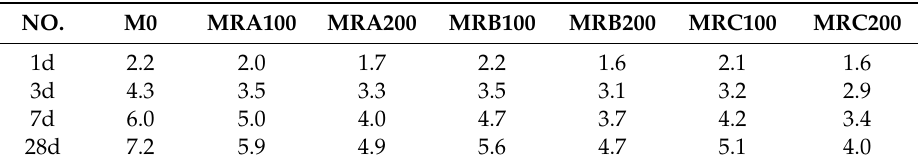
Table 6. Flexural strength of mortars